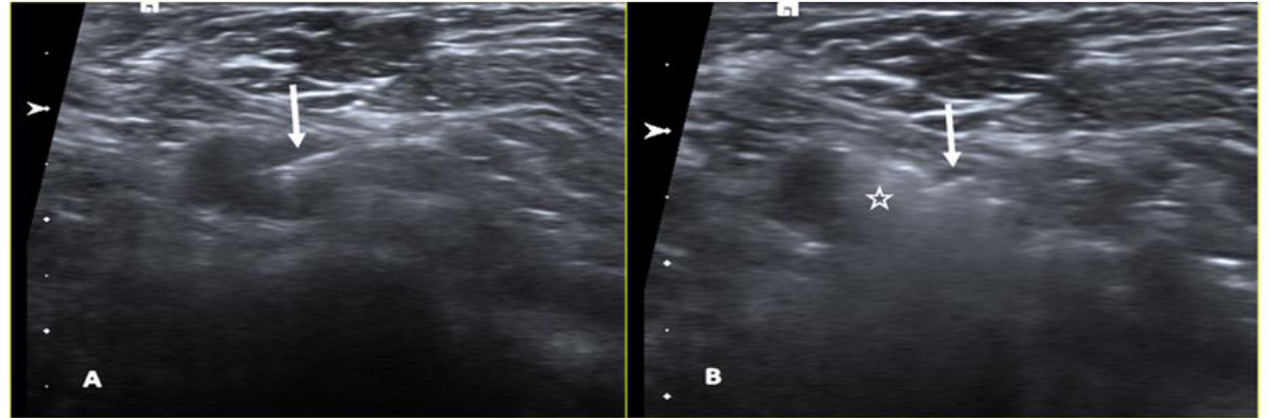
Figure 8. A 55-year-old patient with right breast cancer and ipsilateral axillary node metastasis treated with neoadjuvant treatment. The axial ultrasound image shows the injection of the radiotracer ( 99m Tc-Nanoscan) in the pathological node through a 21-gauge steel needle (arrow in ( A , B )), which appears typically hyperechoic (star in ( B )).